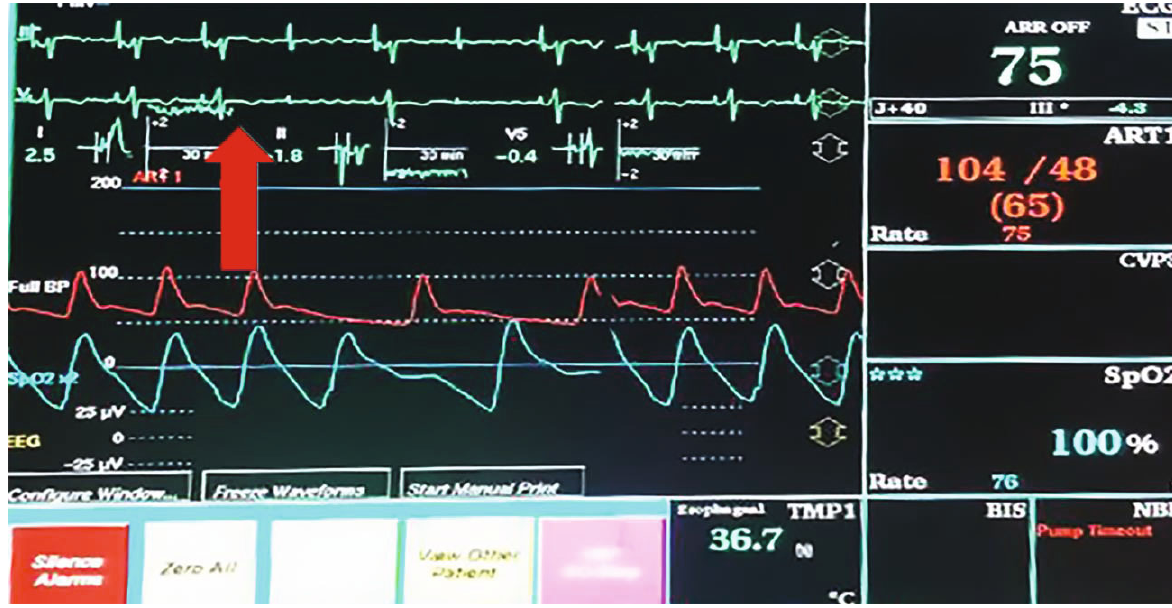
Figure 1: Monitor demonstrating intermittent loss of ventricular capture during RFA